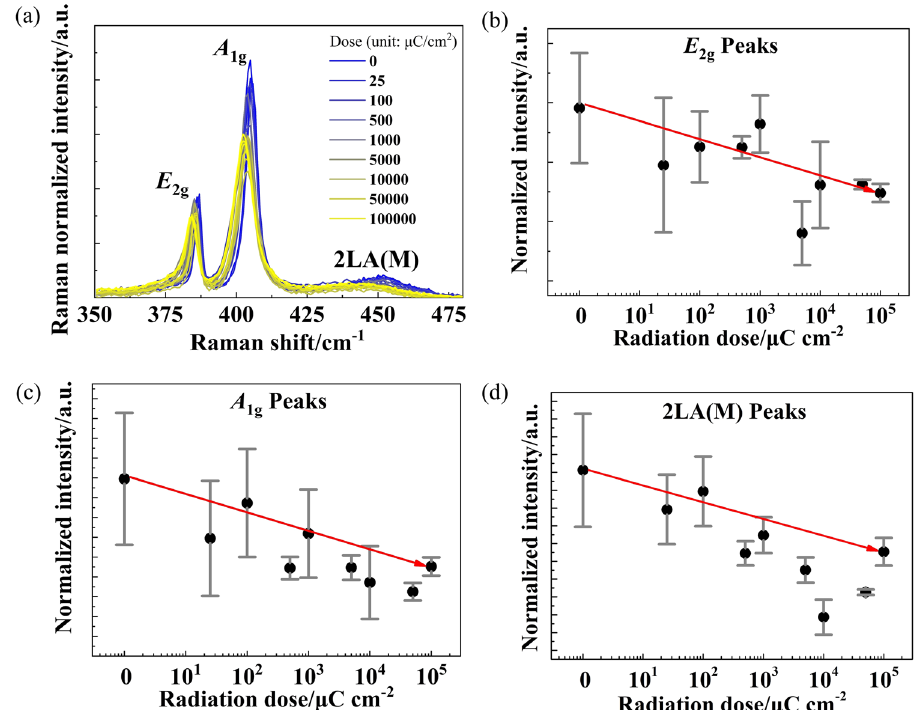
Fig. 3 Raman spectra analysis of the irradiation effect on monolayer MoS 2 . a The Raman spectra of monolayer MoS 2 with different radiation doses up to 10 5 μ C/cm 2 . The peaks for unirradiated sample at ~386 cm − 1 ( E 2g ) and 405 cm − 1 ( A 1g ) are consistent with previous reports for monolayer MoS 2 . b E 2g peak intensity, ( c ) A 1g peak intensity, and ( d ) 2LA(M) peak intensity with different radiation doses. A decrease of intensity can be observed as dose increases. The 2LA(M) peak disappears at high radiation doses. These suggest sulfur vacancies are introduced to the MoS 2 fi lm after irradiation. The Raman spectra are measured on three different locations for each dose to compensate for variation from material